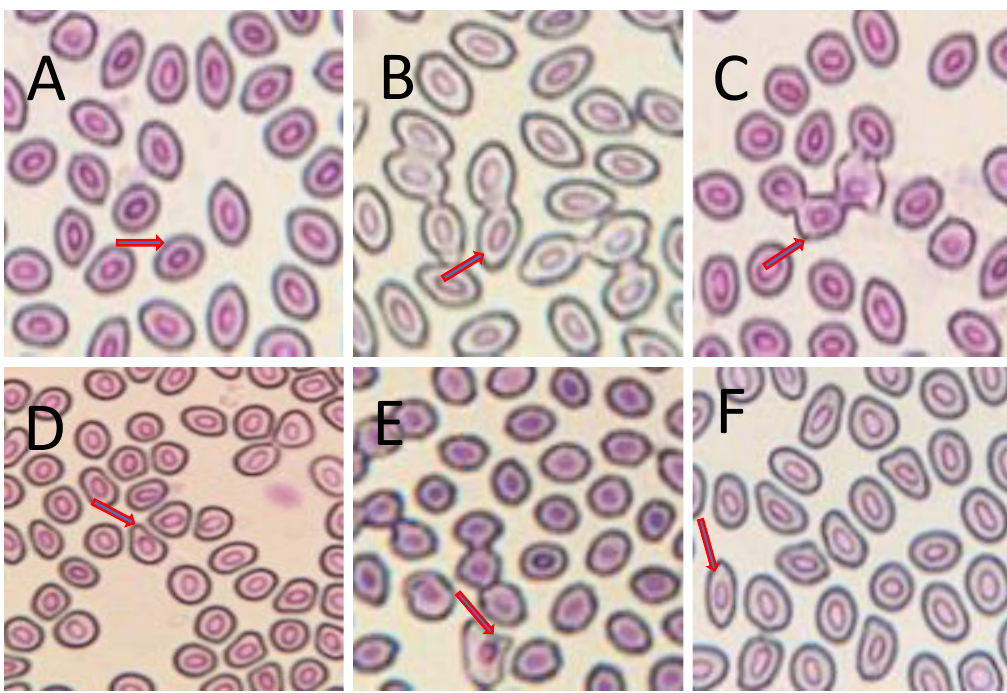
Figure 3. Various erythrocytic cellular abnormalities (ECA) in Giemsa-stained blood smears of climbing perch exposed to different concentrations of ethinylestradiol (EE2)/desogestrel (DES) mixture. Arrows indicate different abnormalities—( A ) regular (no abnormality), ( B ) twin, ( C ) fusion, ( D ) teardrop-shaped, ( E ) echinocytic, and ( F ) elongated erythrocytes. Table 5. Frequencies of erythrocytic cellular abnormalities (ECA) in climbing perch exposed to different concentrations of ethinylestradiol/desogestrel mixtures.